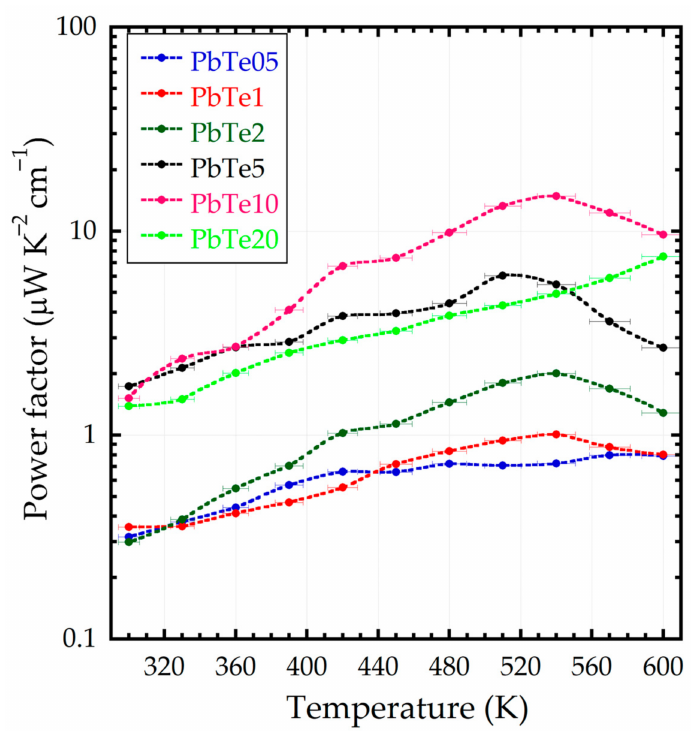
Figure 7. Power factor values as a function of the